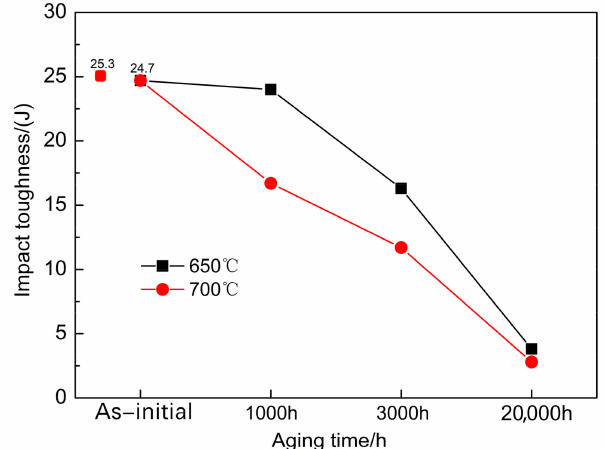
Figure 10. Impact properties at room temperature of Inconel 783 alloy bolts for di ff erent aging times and